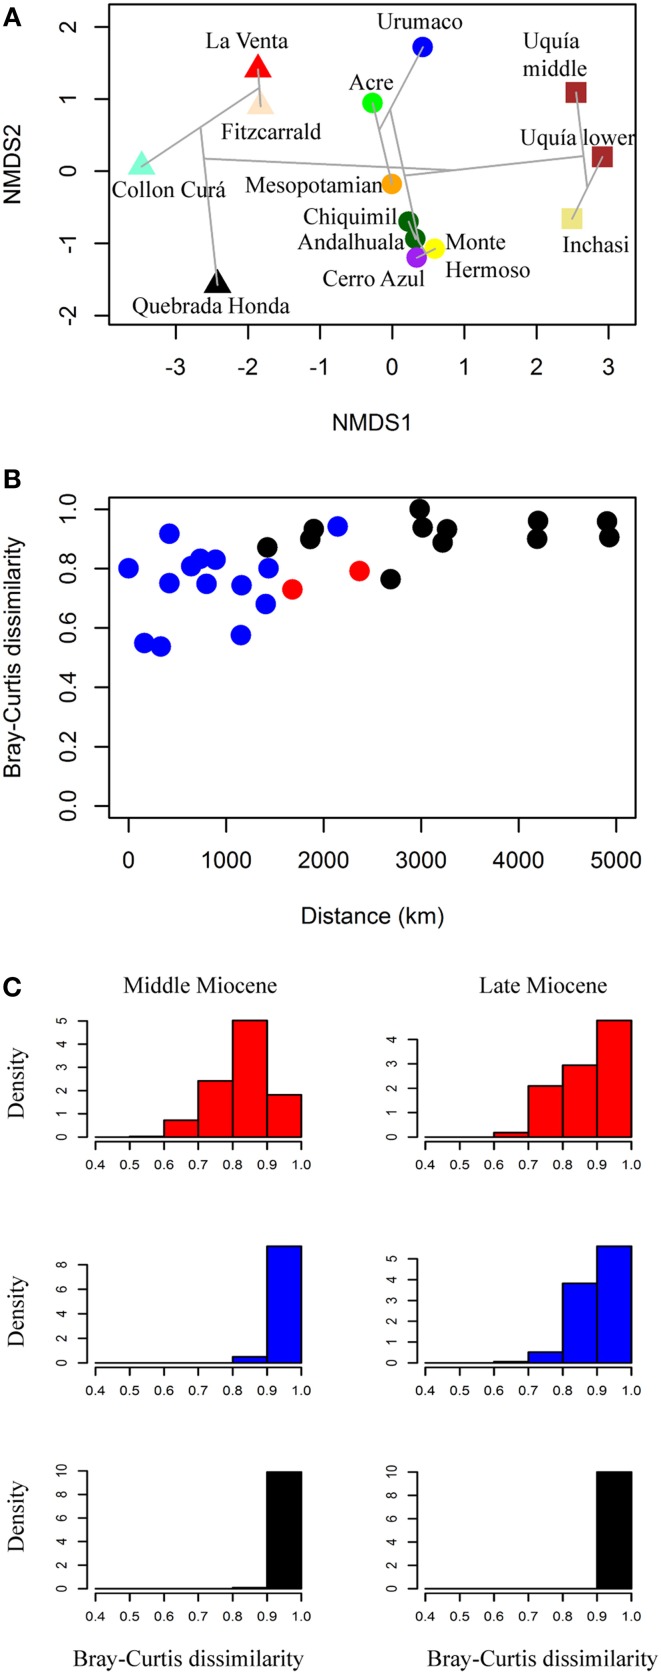
(A) NMDS plot of the faunal associations using Bray-Curtis dissimilarity; triangles, middle Miocene; circles, late Miocene; squares, Pliocene. The gray lines show the clustering result. (B) Bray-Curtis dissimilarity relationship with distance in km, between each locality pair. We include only localities pairs which are within the same time interval (middle Miocene, late Miocene, Pliocene), red, tropical–tropical pair; blue, temperate–temperate pair; black, tropical–temperate pair. (C) Density histograms of the Bray-Curtis dissimilarity values among the different faunal associations analyzed for the middle and late Miocene, red, only tropical faunas, blue, only temperate faunas, black, tropical vs. temperate faunas.